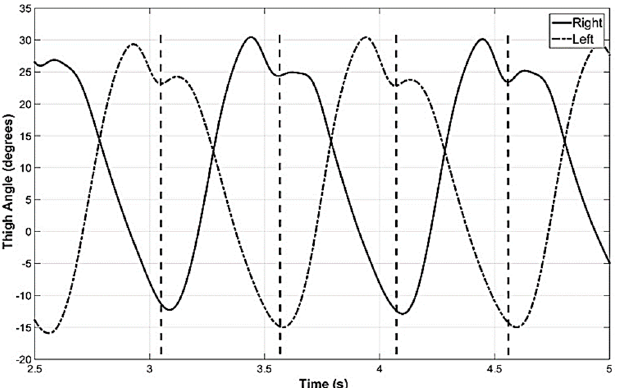
Figure 3. Thigh angle of left and right legs. This indicates that the toe off of one leg is synchronized with the initial contact of the other leg as shown by vertical dashed lines.